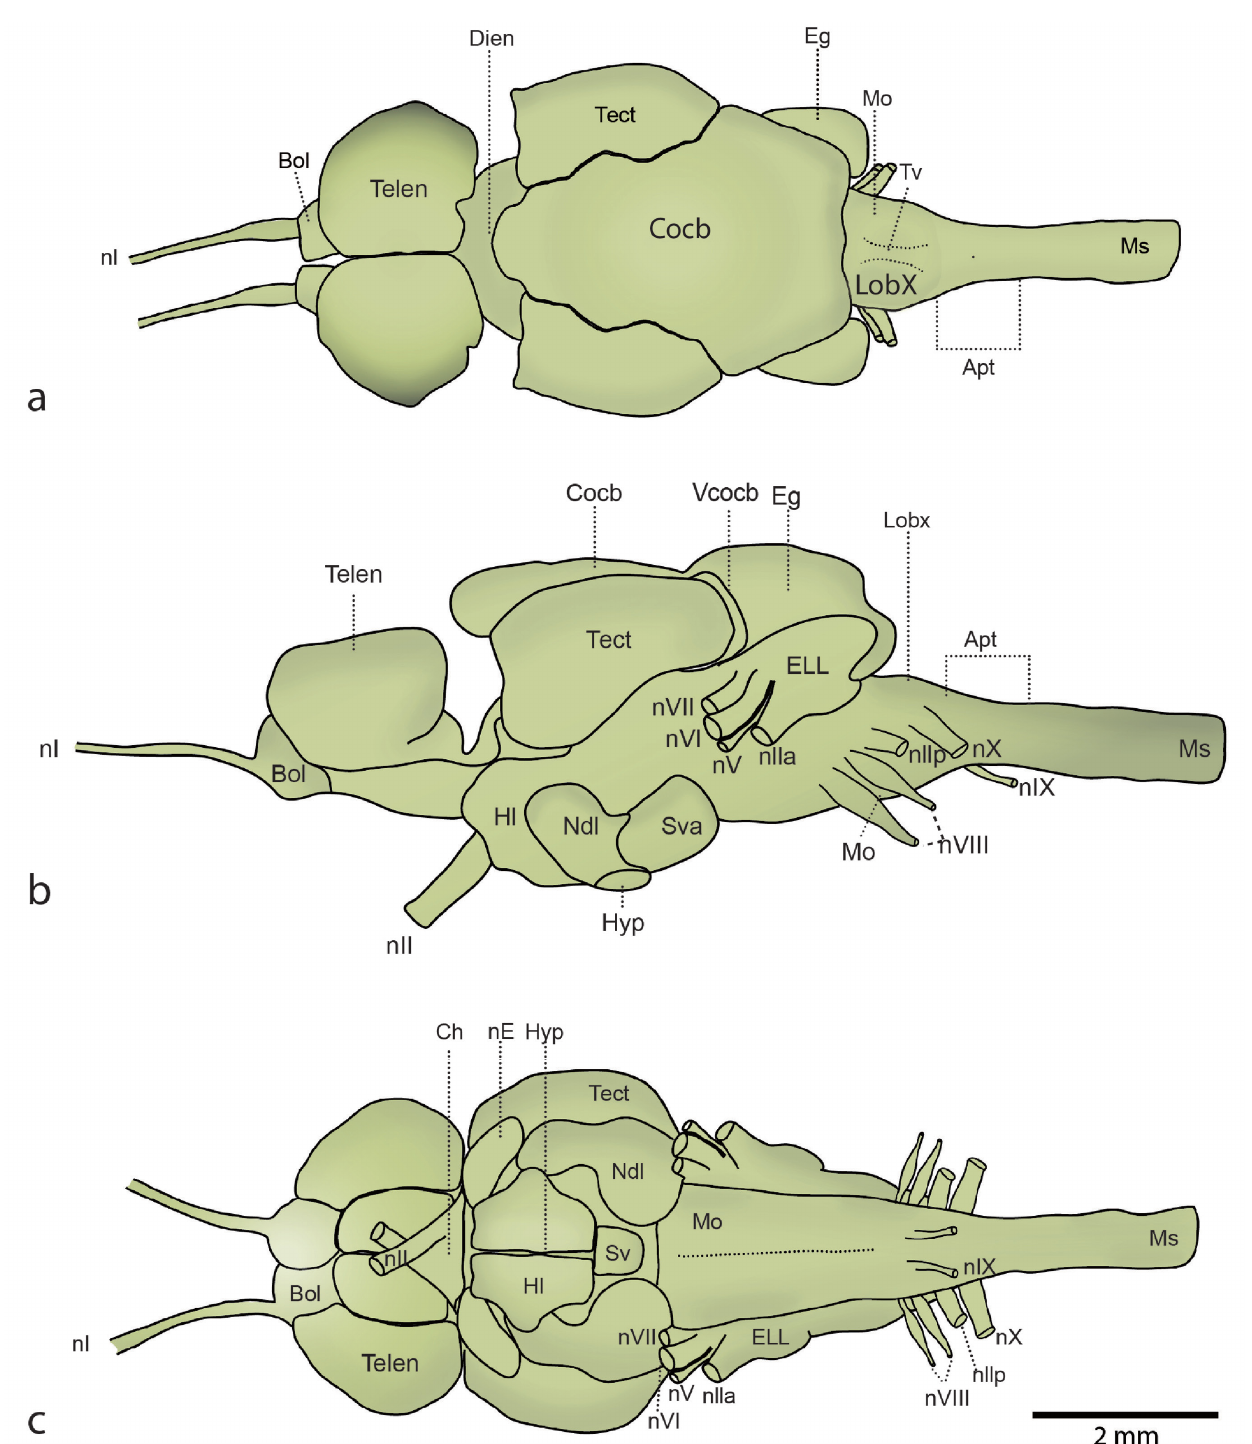
Fig. 5. Brain of Gymnotus carapo (Gymnotiformes: Gymnotidae), LIRP 7767, 129.0 mm SL. a. dorsal; b. lateral and c. ventral views. Apt = Area postrema ; Bol = bulbus olfactorius ; Ch = chiasma opticum ; Cocb = corpus cerebelli ; Dien = diencephalon ; Eg = eminentia granularis ; ELL = electrosensory lateral line lobus; Hl = lateral nucleus of hypotalhamus ; Hyp = hypophysis ; LobX = lobus vagi ; Mo = medulla oblongata ; Ms = medulla spinalis ; ndl = lateral portion of nucleus diffusus ; nE = nucleus electrosensorius ; Sv = saccus vasculosus ; Tect = tectum opticum ; Tv = tela ventriculi ; Vcocb = valvula cerebellum. Cranial Nerves : nI = nervus olfactorius ; nII = nervus opticus ; nV = nervus trigeminus ; nVI = nervus abducens ; nVII = nervus fascialis ; nVIII = nervus octavus ; nlla = nervus lineae lateralis anterior ; nllp = nervus lineae lateralis posterior ; nIX = nervus glossopharyngeus ; nX = nervus vagus